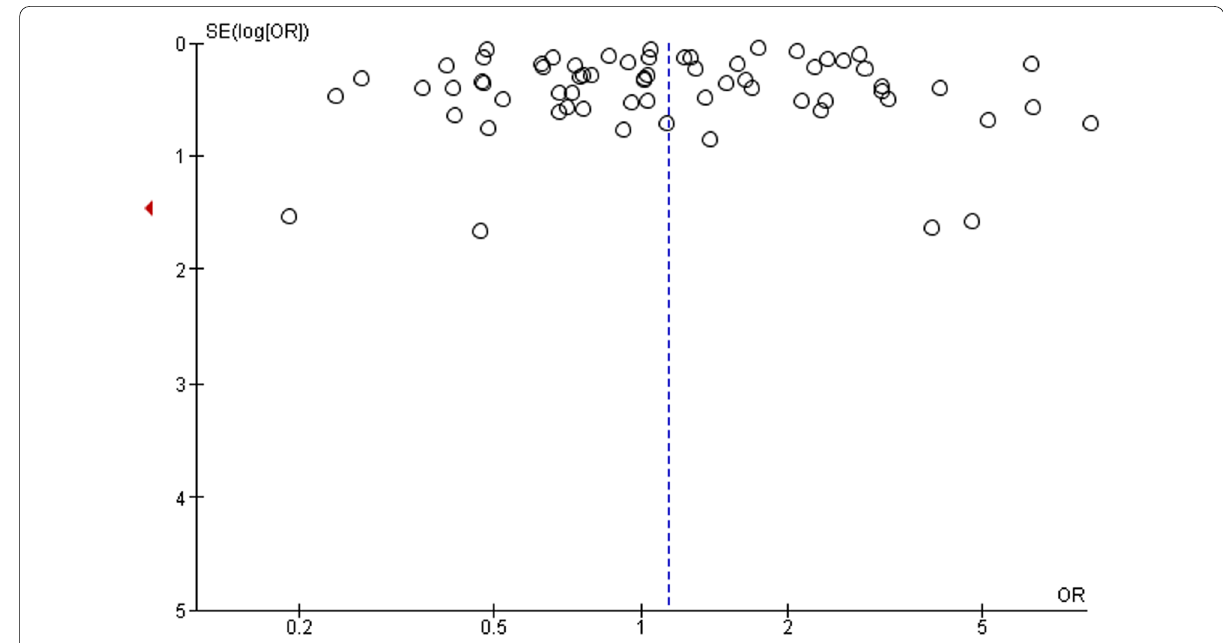
Fig. 3 Funnel plot for the assessment of publication bias